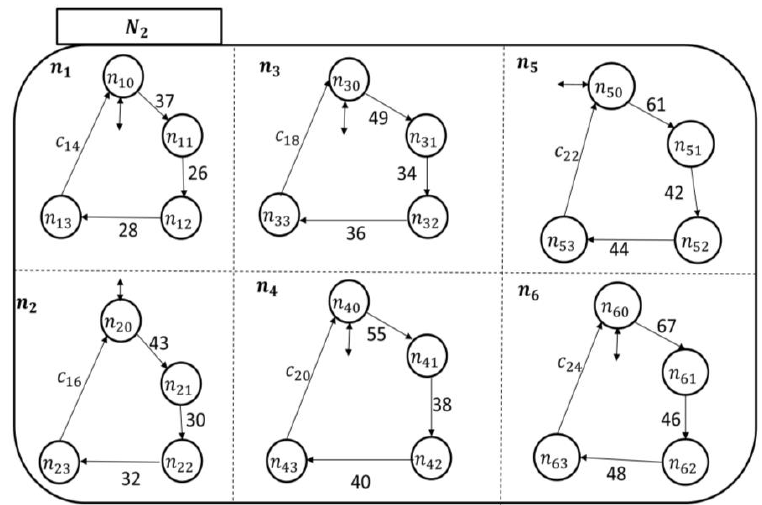
Figure 15. The nursing station automaton (𝑵 𝟐 ) transitional model.